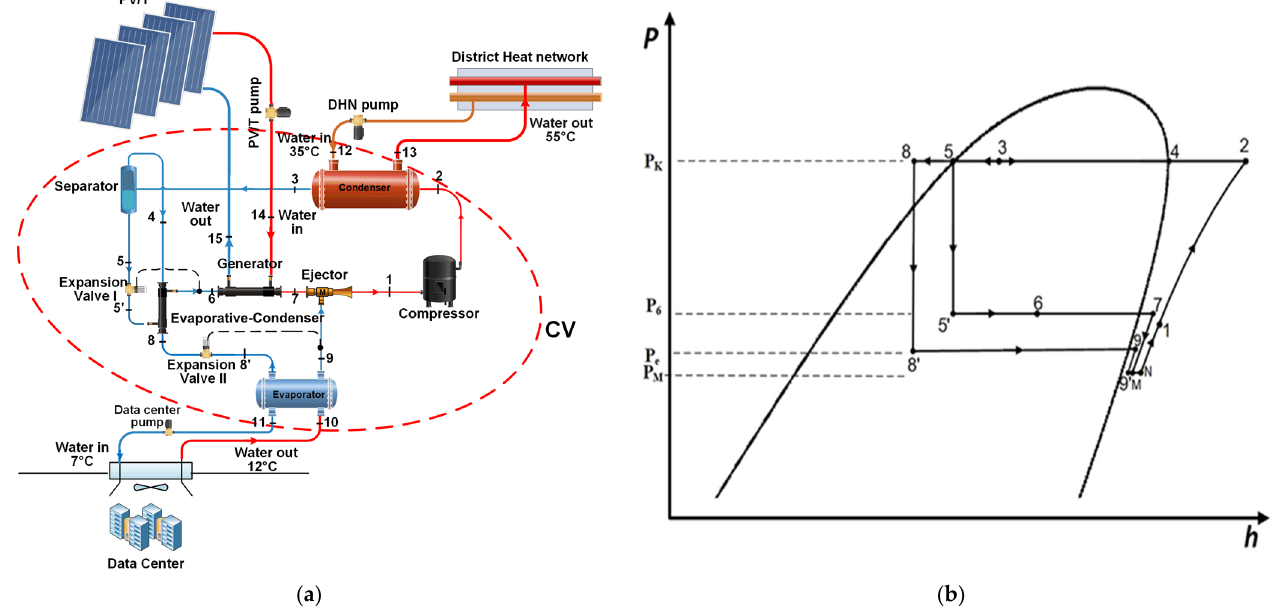
Figure 1. Proposed solar-driven ejector-compression system: ( a ) schematic, and ( b ) P-h diagram.